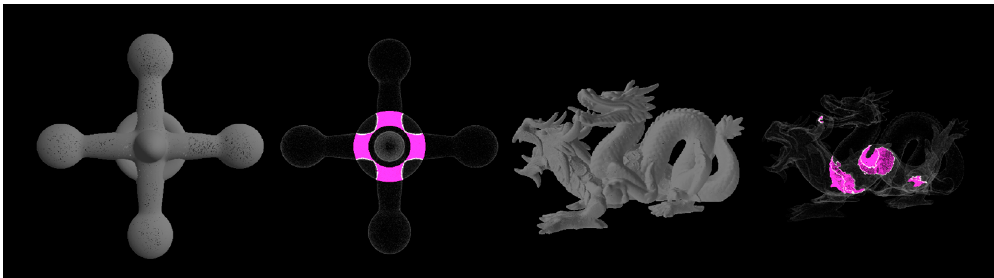
Figure 7. Examples for visualizing the collision areas between point-based surfaces. The left images show the collision areas of a hub with a torus. The right images show the collision areas between two types of dragons.